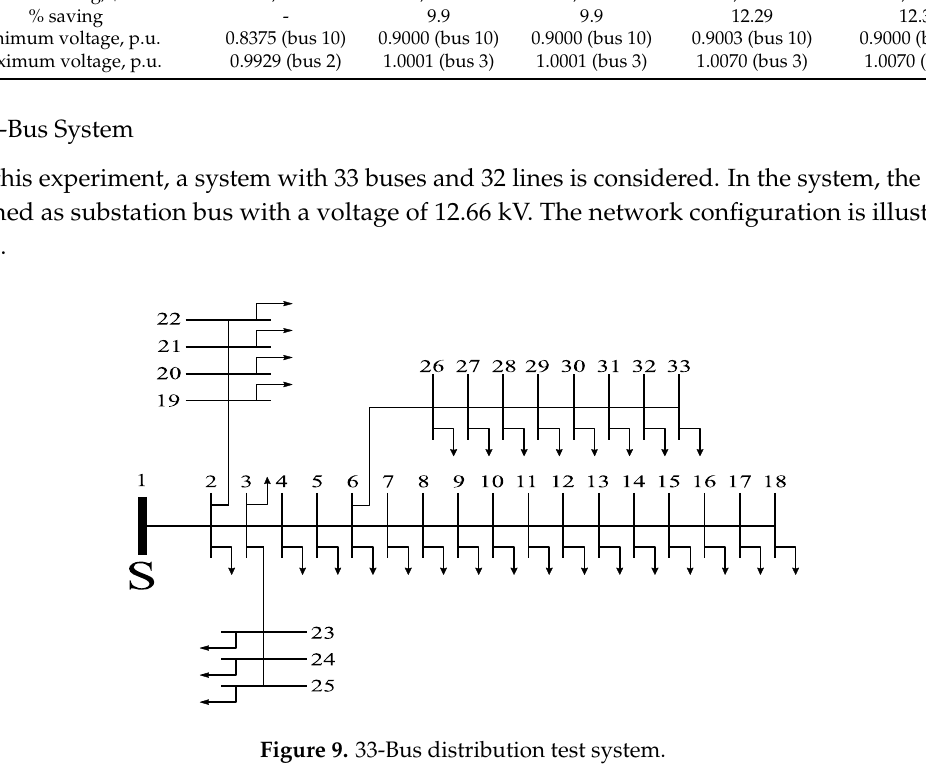
Figure 9. 33-Bus distribution test system.